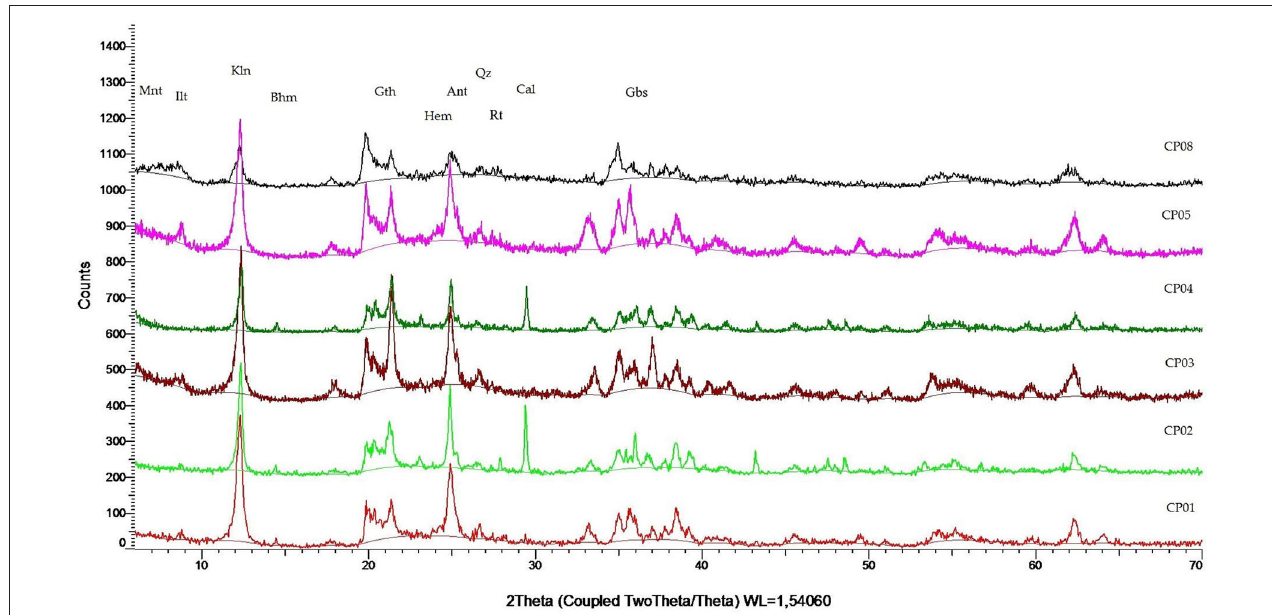
FIGURE 5 | XRPD patterns of representative CP palaeosol samples. Legend. Kln, Kaolinite; Ilt, Illite; Mnt, Montmorillonite; Plg, Palygorskite; Qz, Quartz; Fsp, Feldspar; Cal, Calcite; Rt, Rutile; Ant, Anatase; Hem, Hematite; Gth, Goethite; Gbs, Gibbsite; Bhm, Boehmite; Hl, Halite.